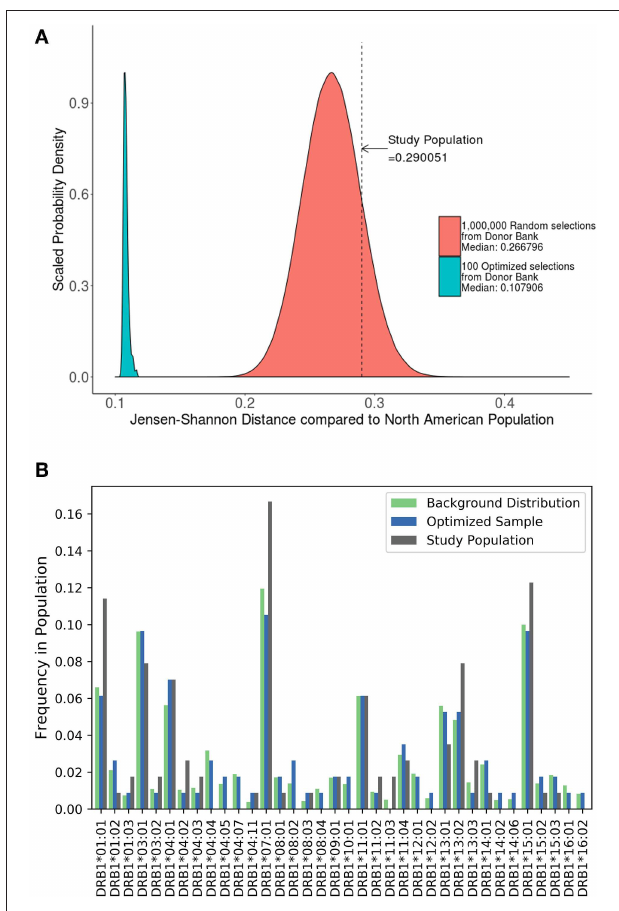
FIGURE 5 | Optimizing a cohort with donors from the same sub-population as the population of interest. (A) A cohort of 57 HLA typed subjects forming the control group in a clinical study were analyzed using the algorithm. The study population had a JSD score which fit within the normal bounds for a population size of randomly selected donors from our available samples (red). However, 100 samples of the same size (green) were created from the same available samples using the algorithm. These optimized samples had a significantly lower JSD score. (B) An analysis of one of these optimized samples (blue) show that it is much closer in distribution to North American Population (green) than study sample (gray). TABLE 3 | A summary of studies that were analyzed in the testing of